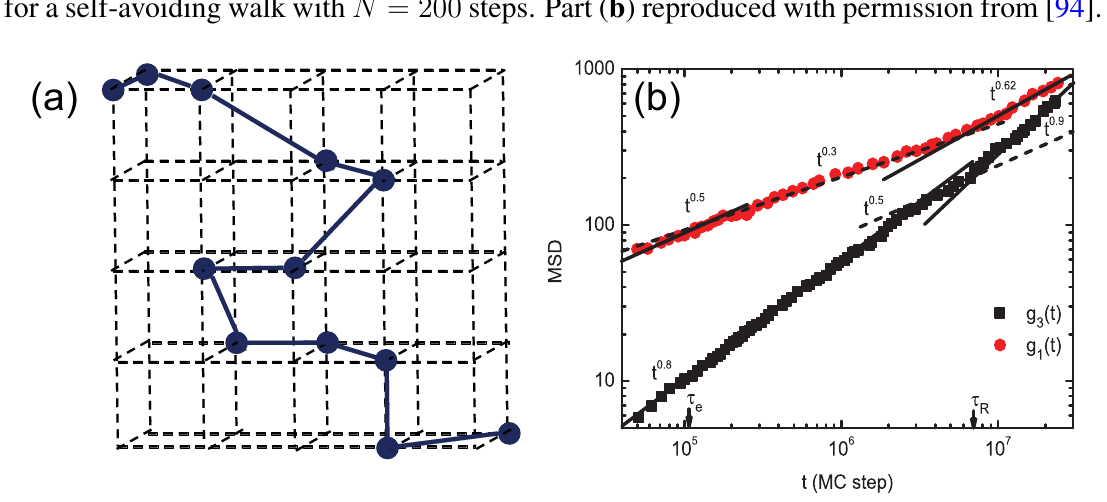
Figure 2. Depiction of ( a ) the bond-fluctuation model and ( b ) mean-squared displacements for a self-avoiding walk with N = 200 steps. Part ( b ) reproduced with permission from